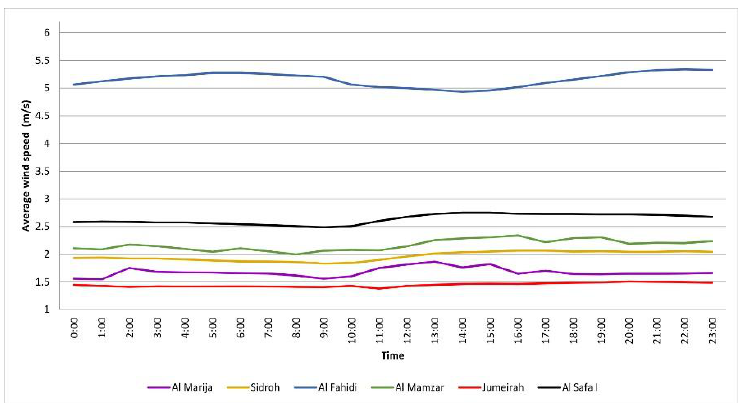
Figure 8. ( a ) Hourly variations of air temperature (°C) for Al Marija, Sidroh, Al Fahidi, Al Mamzar, Jumeirah, and Al Safa I in August. ( b ) Average air temperature (°C) for daytime, nighttime, and the whole 24 h in August.